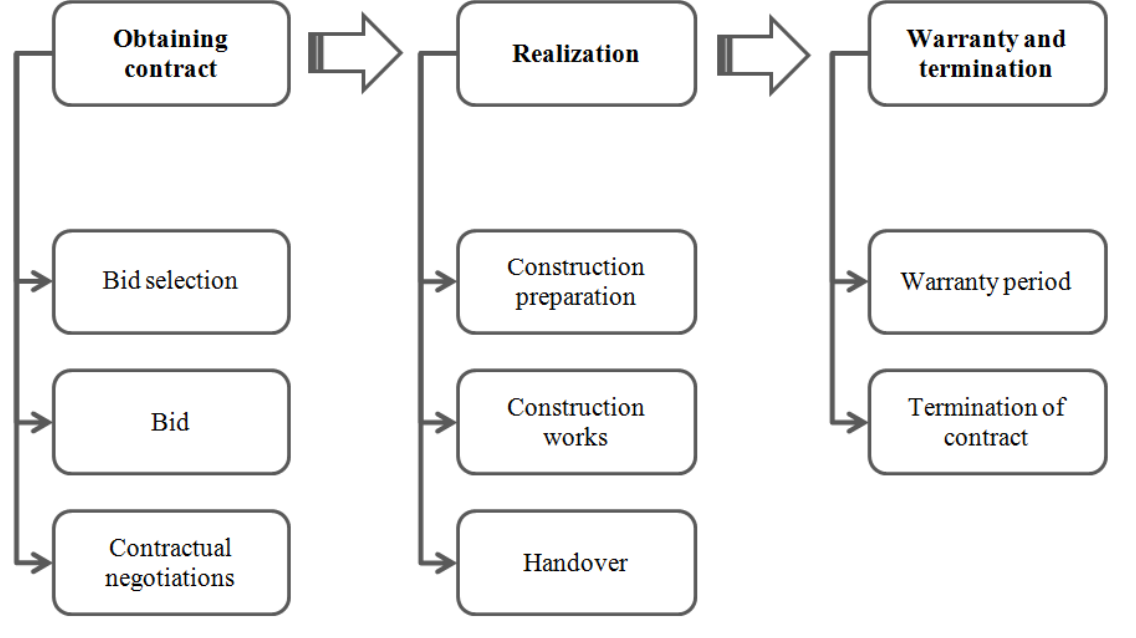
Figure 2: Project management – general contractor (source: